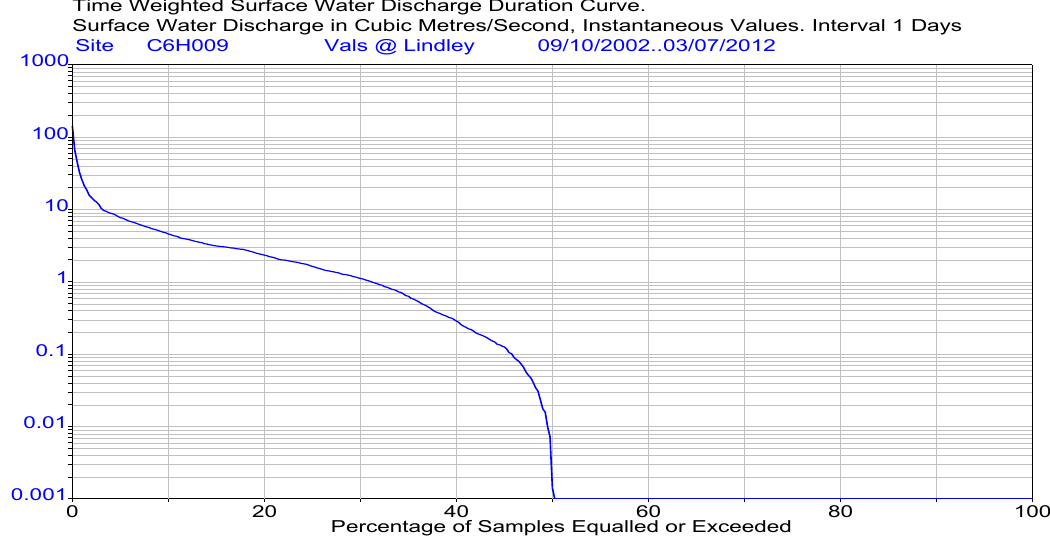
Figure 3: Time-Flow duration curve (Hydstra: 2013a) The only possible surface water source in the Lindley area is the Vals River which flows past the town from east to west. The river water-flow characteristics registered at the flow gauging station C6H009 located at Lindley (Vals River: Latitude -27.87250000, Longitude 27.91416667) are shown in Figures 3 and 4. From Figure 3 it can be seen that between 9 October 2012 and 3 July 2012 the river only had water flowing in it 50% of the time.